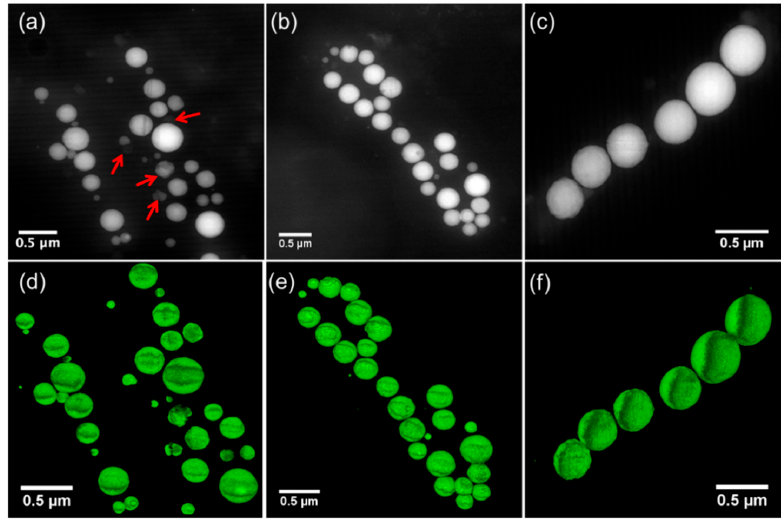
Figure 6. HAADF-STEM tomography of Ca . G. lithophora C7. ( a – c ) HAADF-STEM images of C7 cell(s) grown in BG-11 ( a ) or in the aquarium ( b , c ) and selected for tilt series acquisition and tomographic reconstruction. ( d – f ) 3-D visualization of the reconstruction from carbonates showing in ( a – c ). See movies in supplementary data. The red-line arrows indicate polyphosphate inclusions.